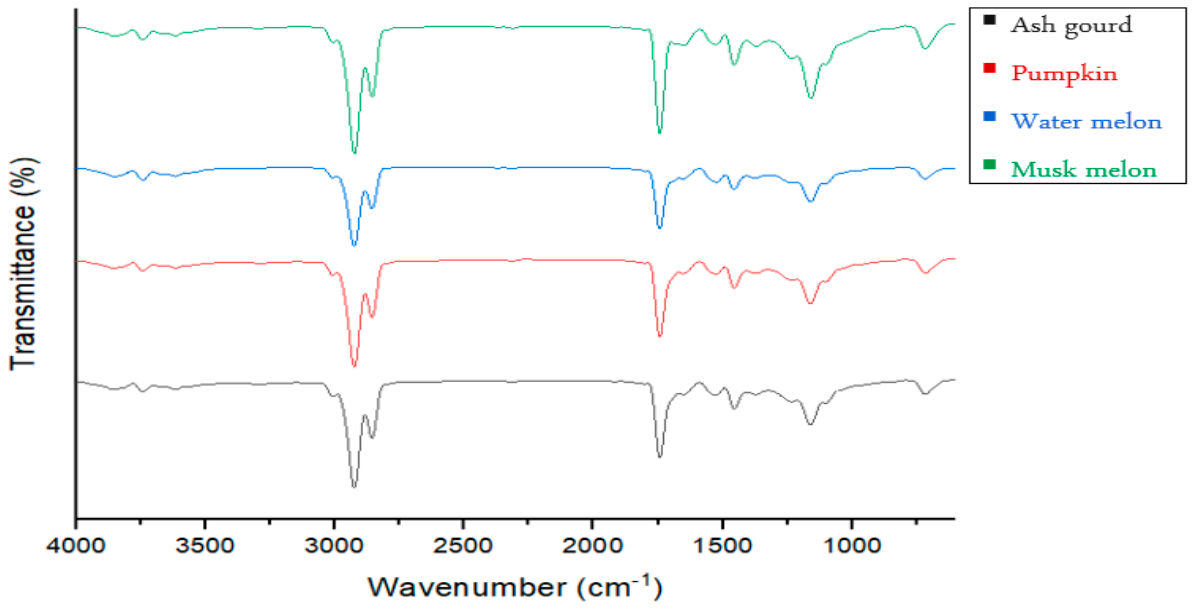
Figure 2. Fourier transform infrared spectra of seeds.